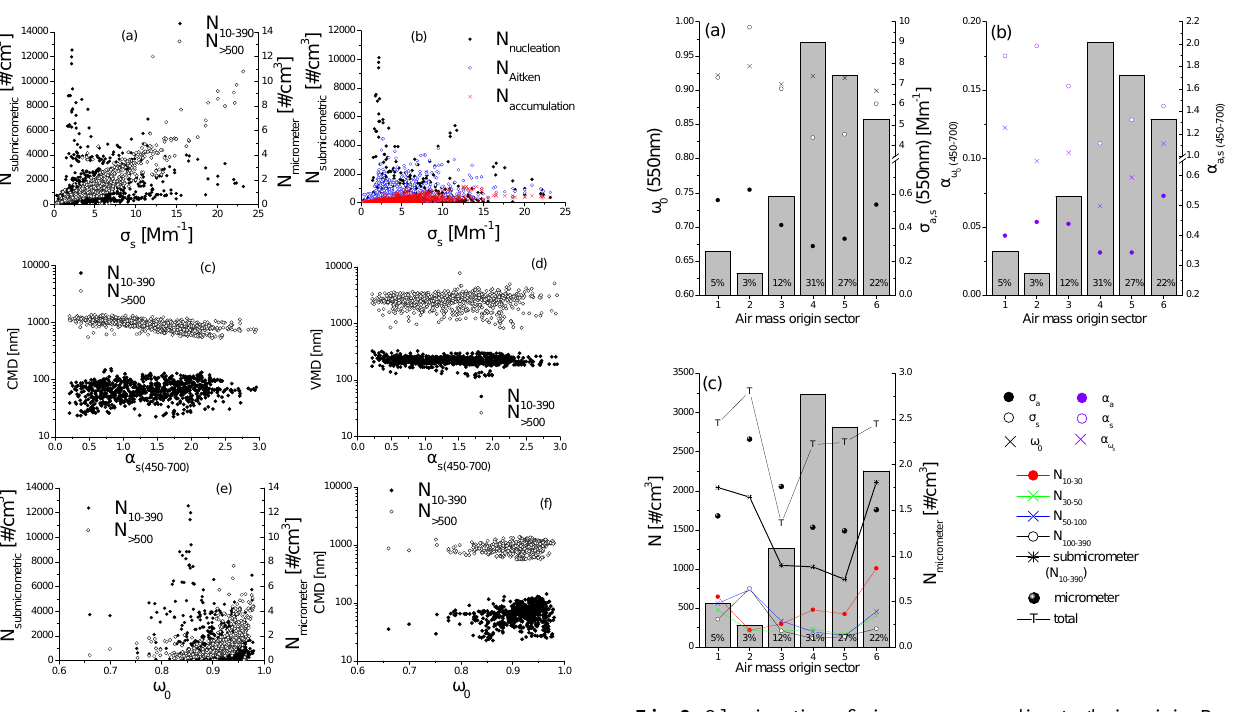
Fig. 7. Relation between σ s and (a) micrometer and submicrometer concentrations, (b) nucleation, Aitken and accumulation modes. (c) Relation between the size of the particles (CMD) and α s . (d) Rela- tion between the size of the particles (VMD) and α s . (e) Relation between ω 0 and the micrometer and submicrometer concentrations. (f) Particle size (CMD) as a function of ω 0 .